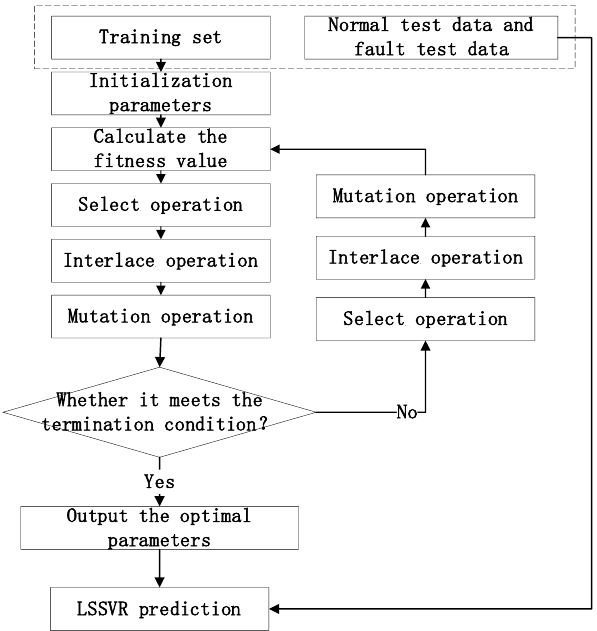
Figure 4. Flow chart of GA-LSSVR.